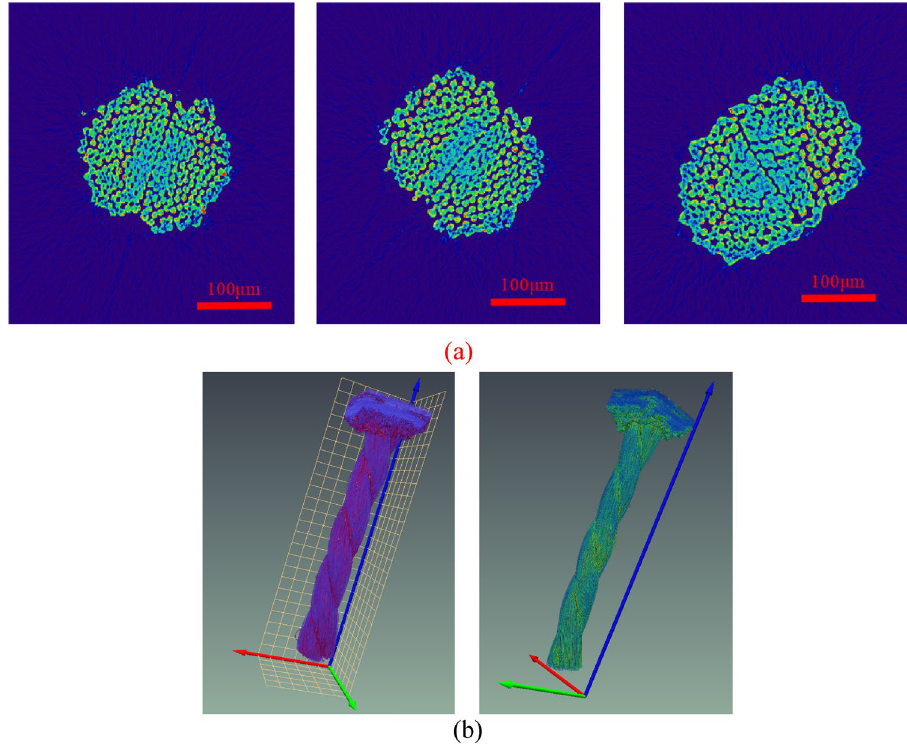
Figure 6. The layered scan and three-dimensional images of nylon.